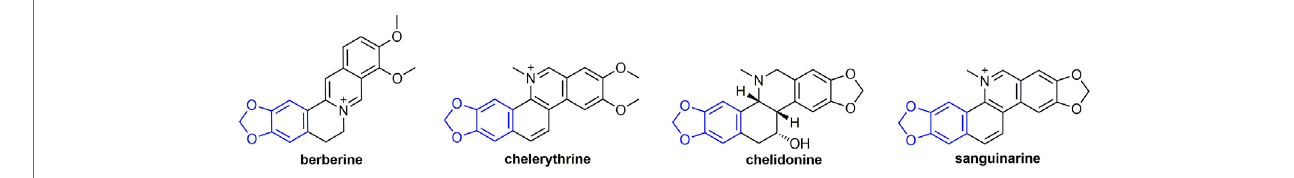
FIGURE 15 | Structures of representative berberine analogs in antiviral